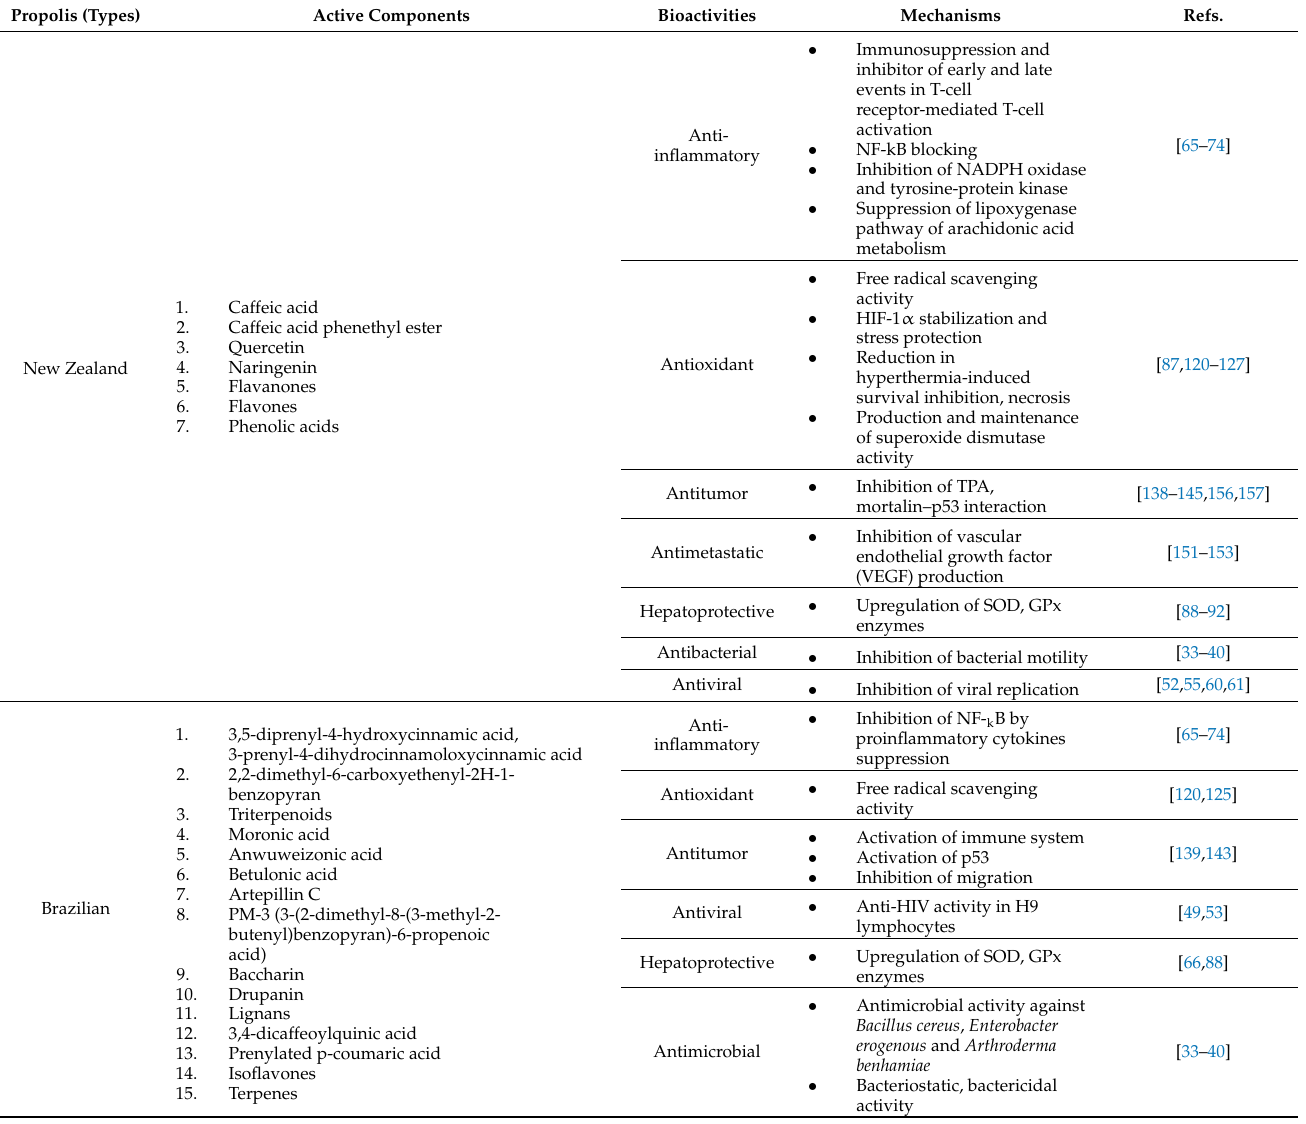
Table 1. Types of propolis and their active components, bioactivities and